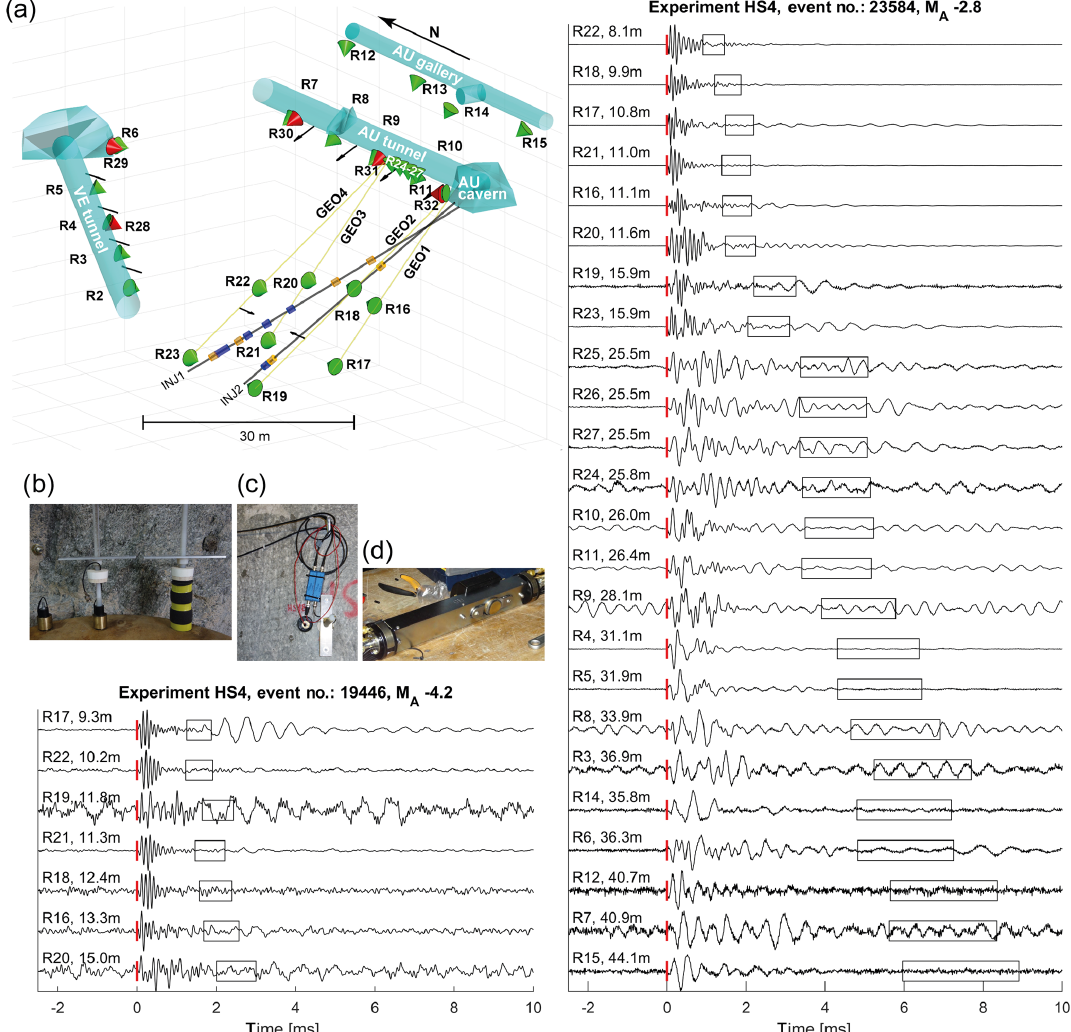
Figure 3. (a) The seismic network consisting of 26 uncalibrated AE sensors (green cones) installed in four boreholes, the AU and VE tunnels, and the AU gallery, along with five one-component calibrated accelerometers (red cones) collocated with five AE sensors in the AU and VE tunnels. Seismic sources in the tunnels and boreholes are shown by black arrows. (b) AE tunnel sensor, insulated against acoustic noise. (c) Installed AE sensor next to a calibrated accelerometer along with their pre-amplifiers. (d) AE sensors in a sensor shuttle for deployment into water-filled boreholes. Waveforms from a small- and large-magnitude event induced during experiment HS4, including the Euclidean distance hypocenter − sensor, P-wave pick (red-stripe), and a window of a hypothetical S-wave arrival for an S-wave velocity of 2500–3000ms − 1 (applied bandpass filter for small event: 1–12kHz; large event: